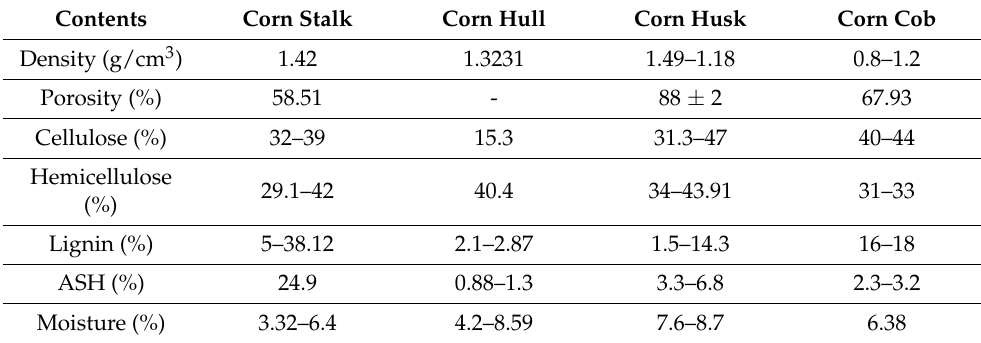
Table 2. Physical properties and chemical composition of corn Stalk, hull, husk and cob